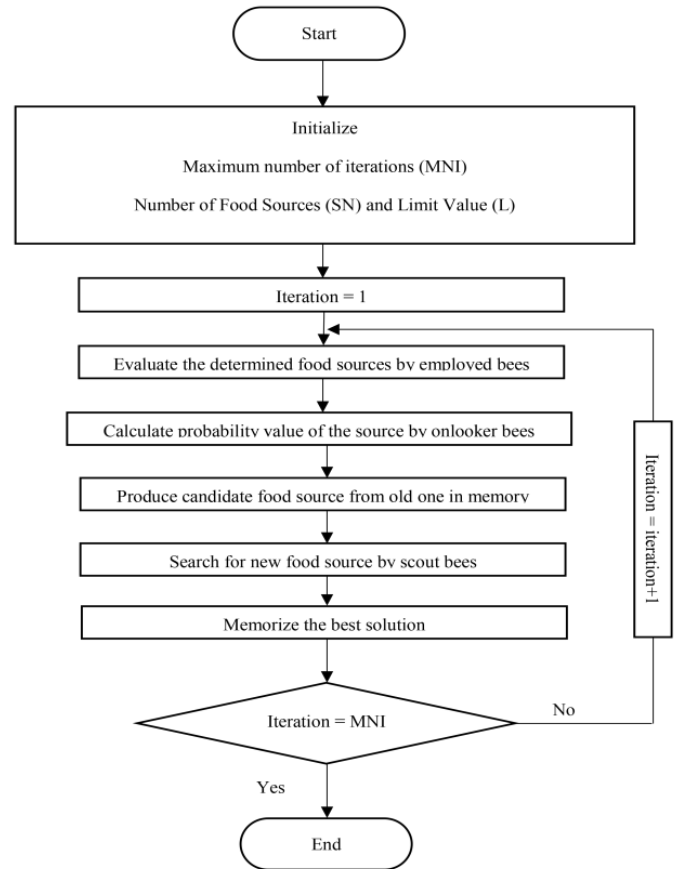
Figure 5. Flowchart of the artificial bee colony (ABC) optimization algorithm.